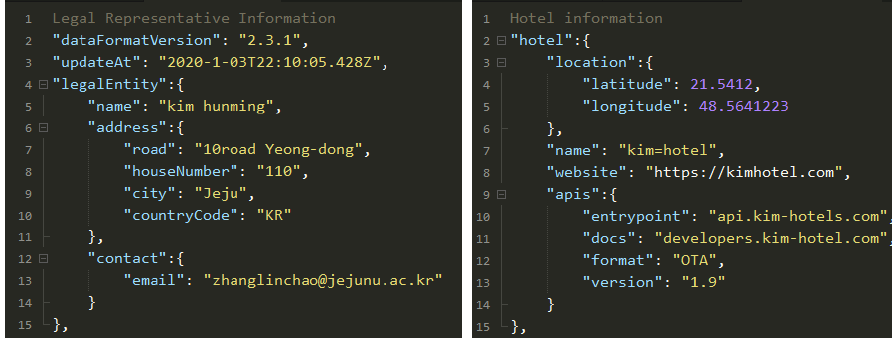
Figure 13. Sample organization content in JSON.